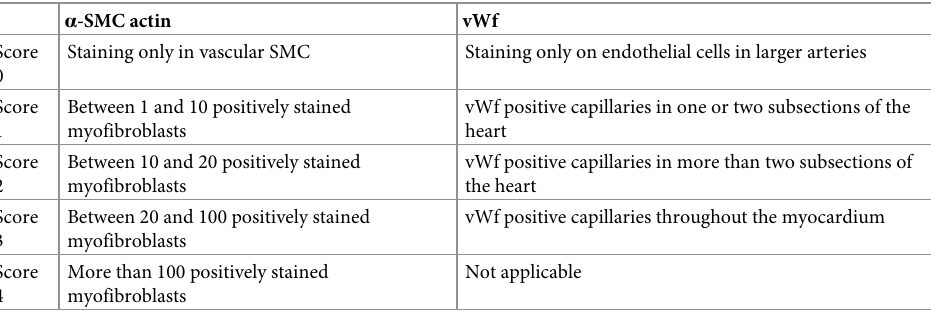
vWf positive capillaries in one or two subsections of the heart vWf positive capillaries in more than two subsections of the heart